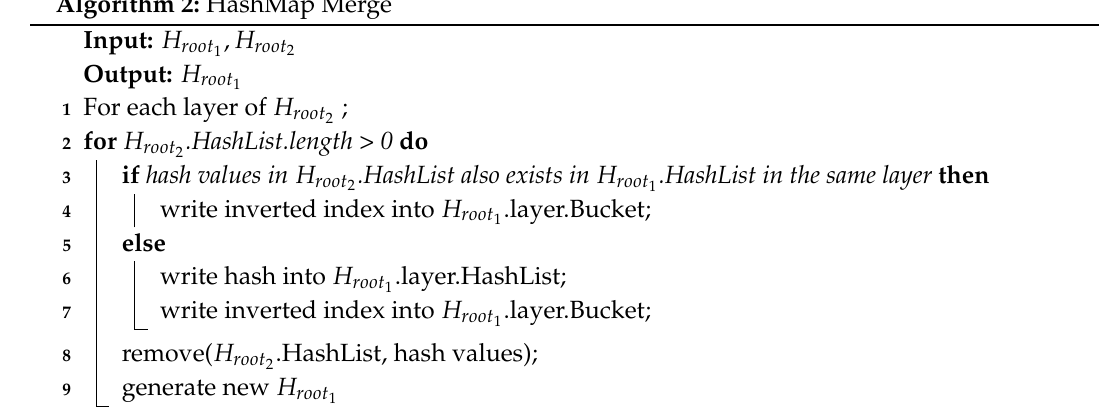
Algorithm 2: HashMap Merge